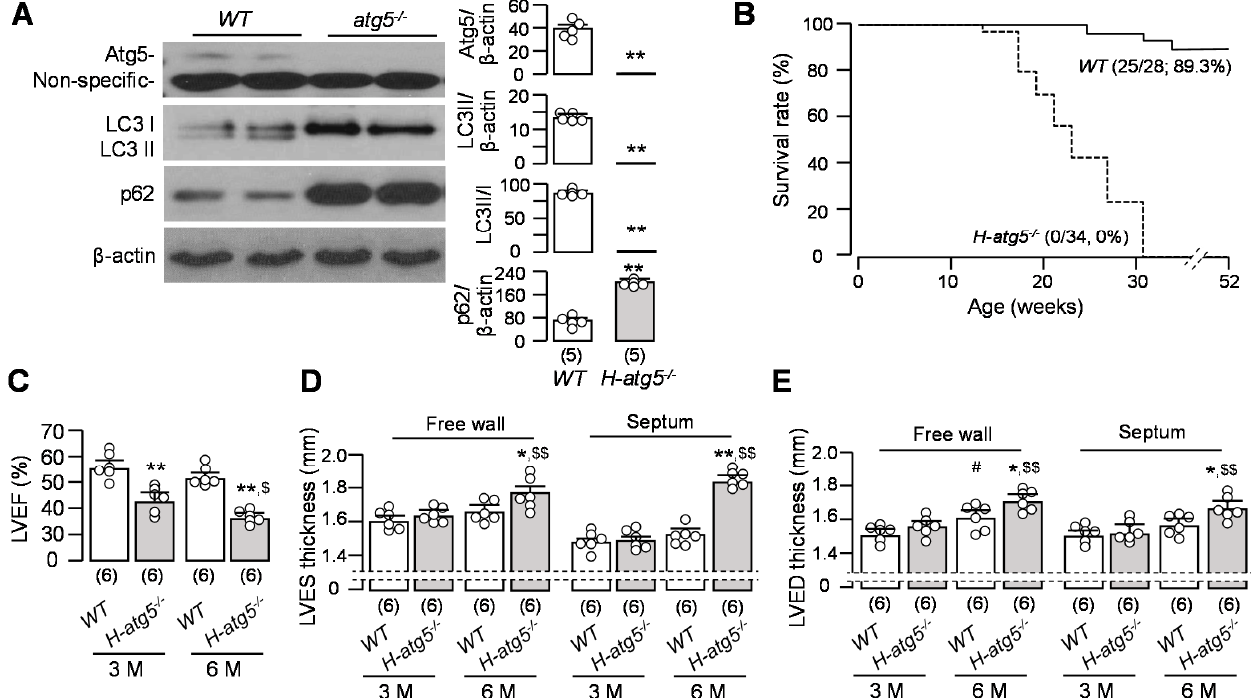
Figure 2. Absence of atg5 in cardiomyocytes induced short lifespan and cardiac dysfunction. ( A ) The changes in autophagic markers and atg5 in the hearts of H-atg5 -/- mice and WT mice at 3 months of age. Left panel: Representative immunoblots for atg5, LC3, and p62 in left ventricular lysates. Right panel: Summary of all immunoblot data. Quantitative data are presented as mean ± SD with scatter plots of individual data points, and statistical significance was assessed by unpaired Student’s t -test. Significant differences are accepted when ** p < 0.01 between two groups. ( B ) Kaplan–Meier survival curves for H-atg5 -/- and WT mice. ( C ) Left ventricular ejection fraction determined by cardiac MRI in H-atg5 -/- mice and WT mice at 3 and 6 months of age. Left ventricular wall thickness at systole ( D ) and at diastole ( E ) determined by cardiac MRI in H-atg5 -/- mice and WT mice at 3 and 6 months old. Sample number in each group is presented in brackets underneath corresponding bar. Quantitative data are presented as mean ± SD with scatter plots of individual data points, and statistical significance was assessed by two-way ANOVA followed by Newman–Keuls test. * p < 0.05, ** p < 0.01 vs. WT mice at the same age; # p < 0.05 vs. WT at 3 months old; $ p < 0.05, $$ p < 0.01 vs. H-atg5 -/- mice at 3 months old.